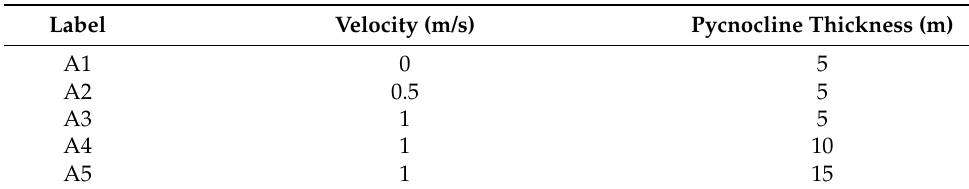
Table 3. Velocity of current and pycnocline thickness in each simulation.